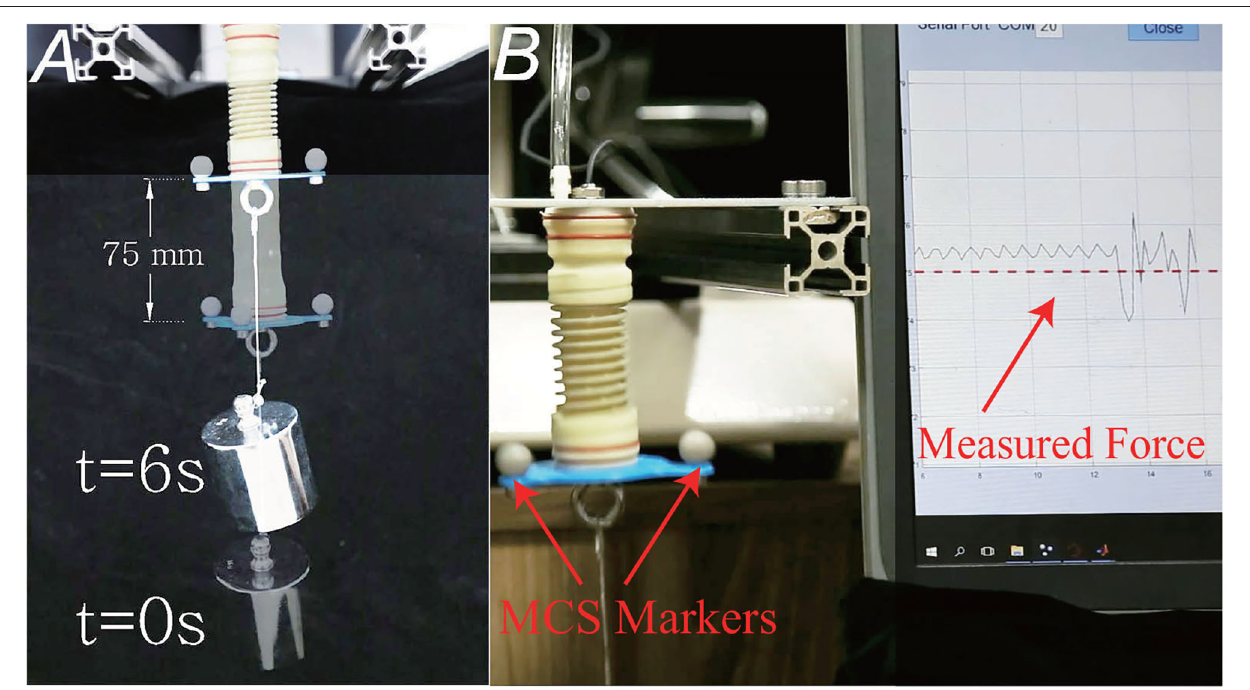
FIGURE 7 | Demonstration of the dynamic performance and impact tests. (A) The position before and after actuation. The actuator is able to lift the 1 kg weight for 75 mm within 6 s. (B) The actuator is able to withstand shocks, as well as roughly detect the intensity of the impact, and whether it touches the target object or interferes with obstacles. When the external impact happens, the internal sensor’s measured value will have a large